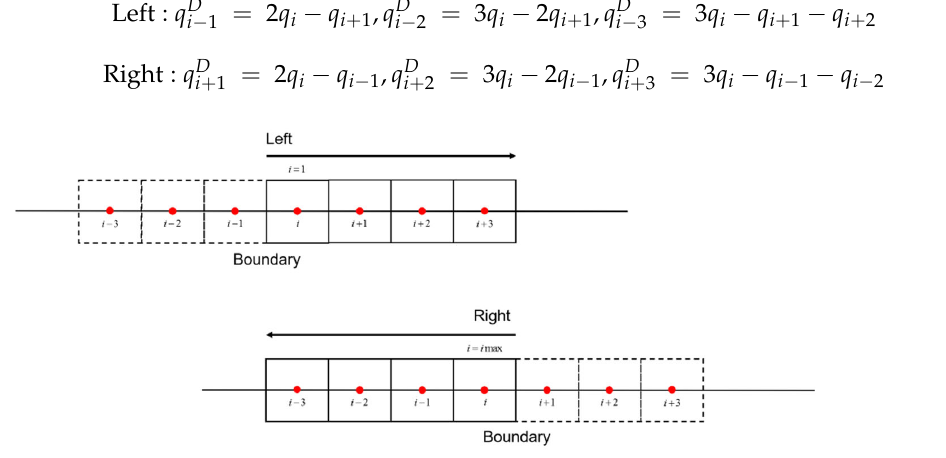
Figure 4. Sketch of the three ‐ layer dummy cell.